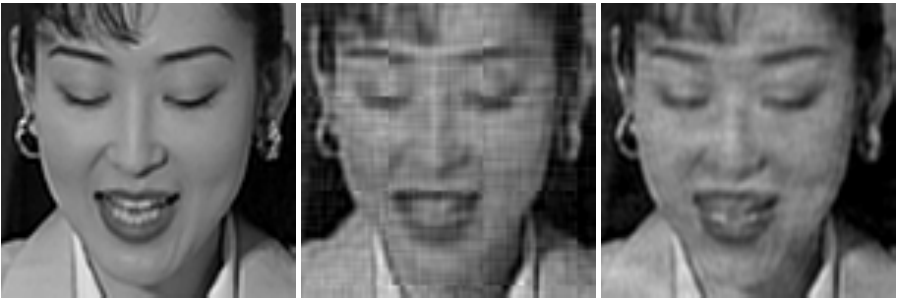
Figure 16. Zoom detail from Figure 15. “Akiyo” frames received from a transmission with a bandwidth ratio of 0.1 and a SNR of 10dB. Left-hand side : original frame. Center : JSCC-Cast with SSIM quality of 0.67. Right-hand side : Softcast with SSIM quality of 0.76.